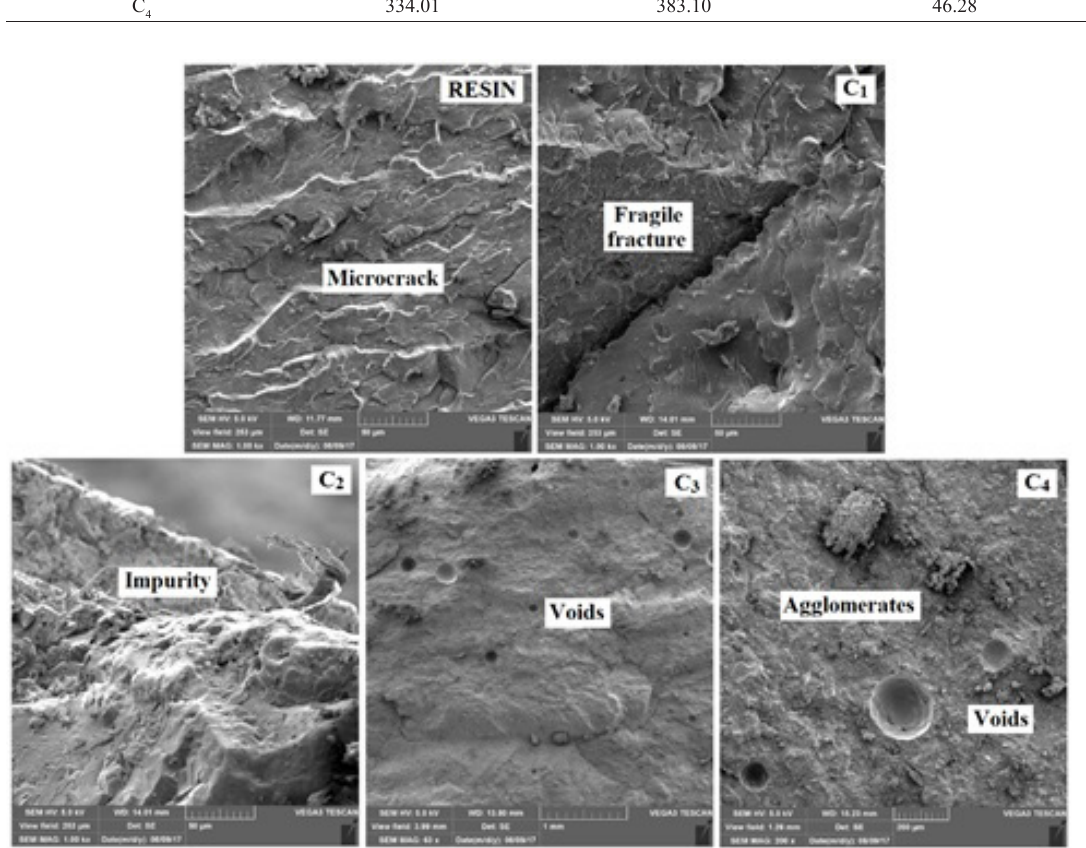
Figure 3. The SEM of all composites and polyester resin, highlighting the defects resulting from their manufacturing process.